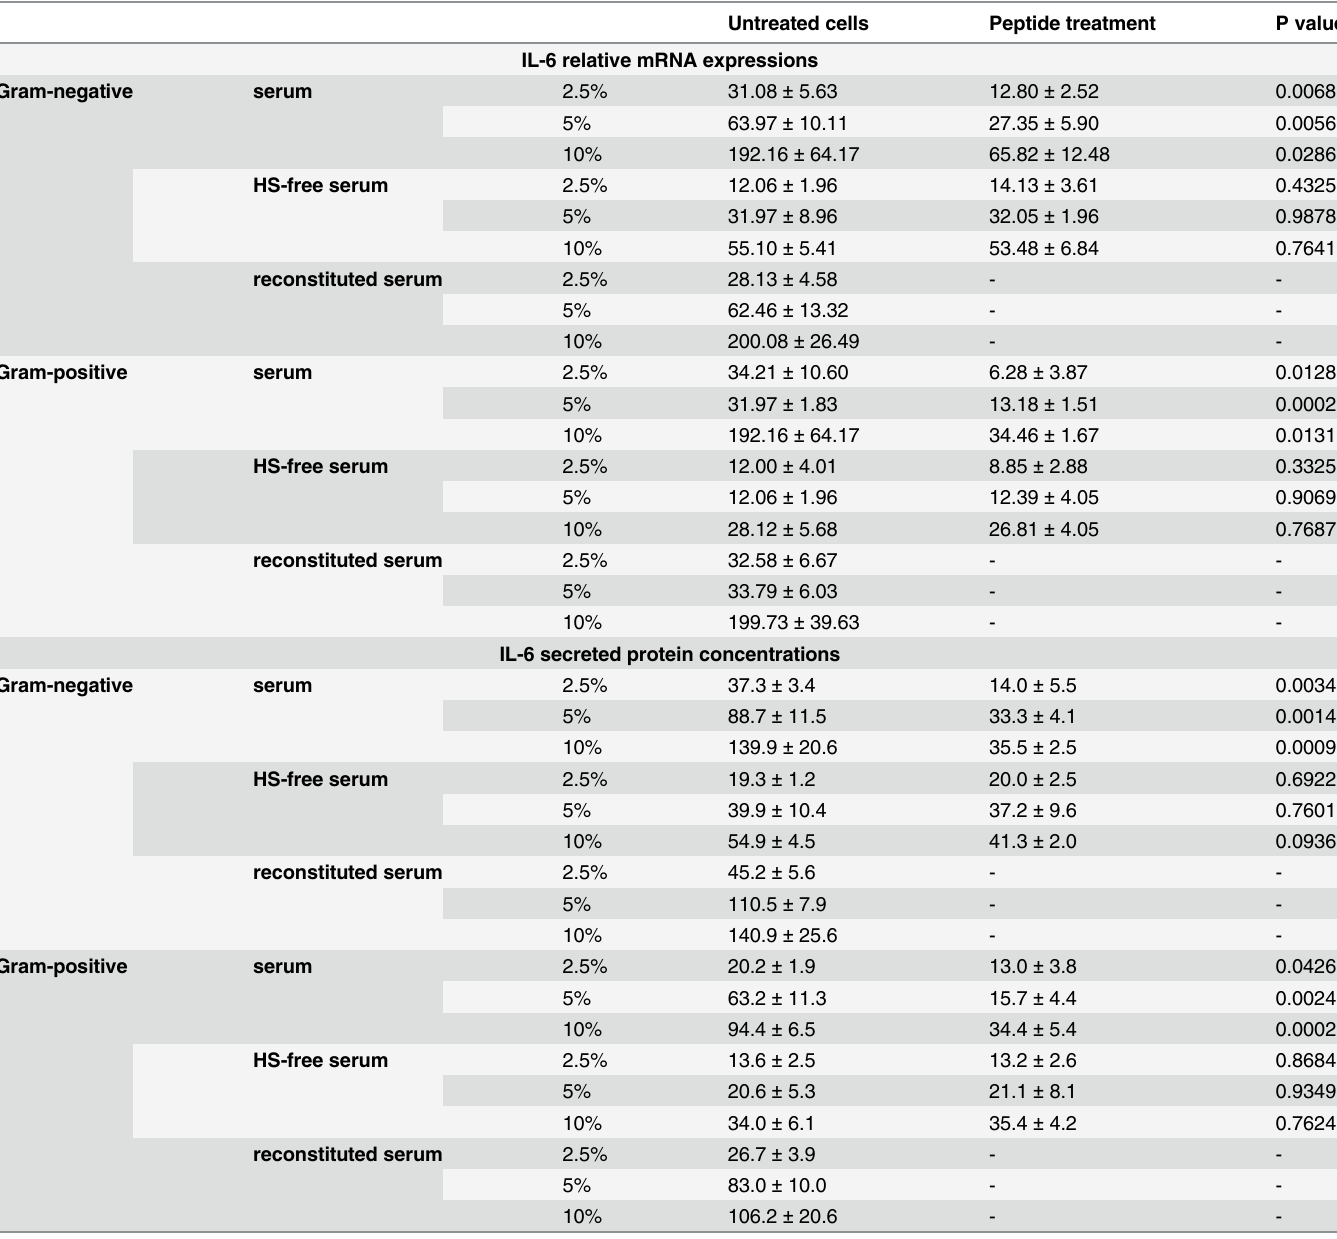
Table 3. IL-6 mRNA expressions and secreted protein concentrations of HL-1 cells stimulated with sera from patients with septic